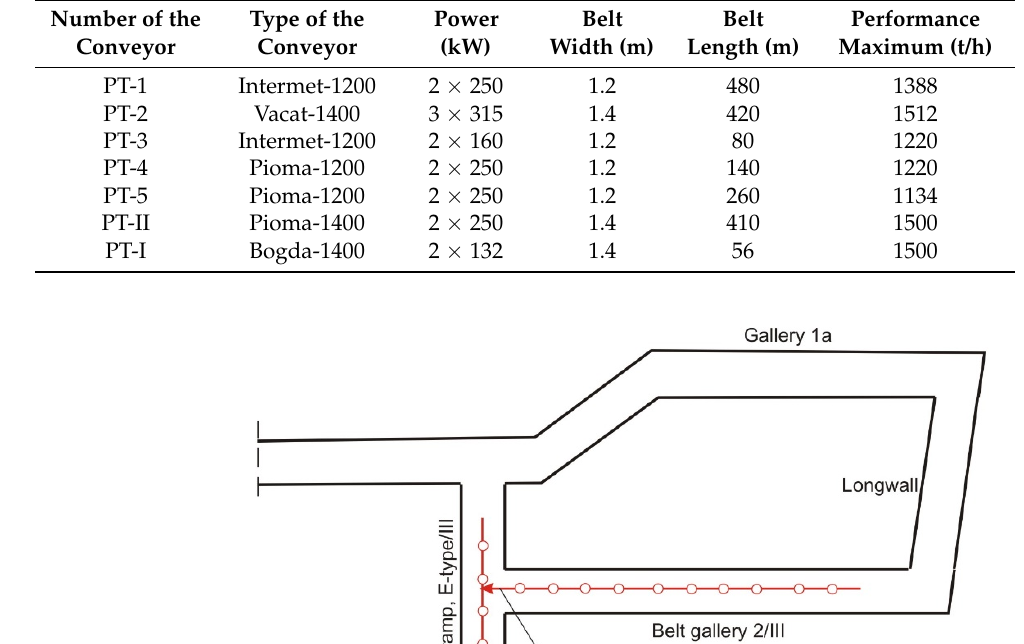
Table 1. Technical parameters of the analysed main haulage system.